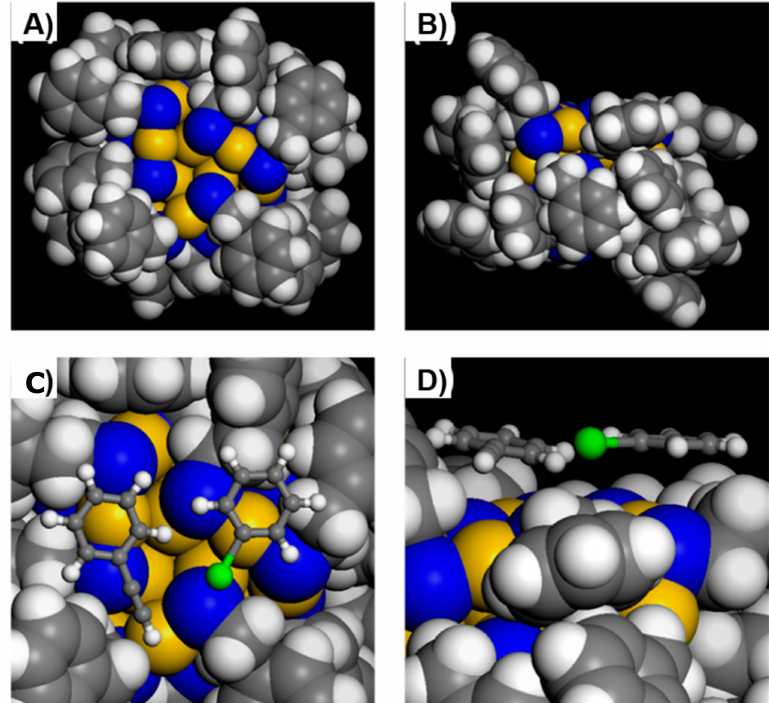
Figure 7. ( A ) Top view of one of the two open facets of Au 25 (PET) 18 clusters where three external Au atoms are exposed; the other facet is on the back side. ( B ) Side view of the two facets which are at top and bottom. ( C ) Top view and ( D ) side view of the co-adsorption of PA and IB on the surface of the Au 25 (PET) 18 clusters. Color code: Au, yellow; S, blue; C, gray; H, white; I, green. Reproduced with permission from [49]. Elsevier,